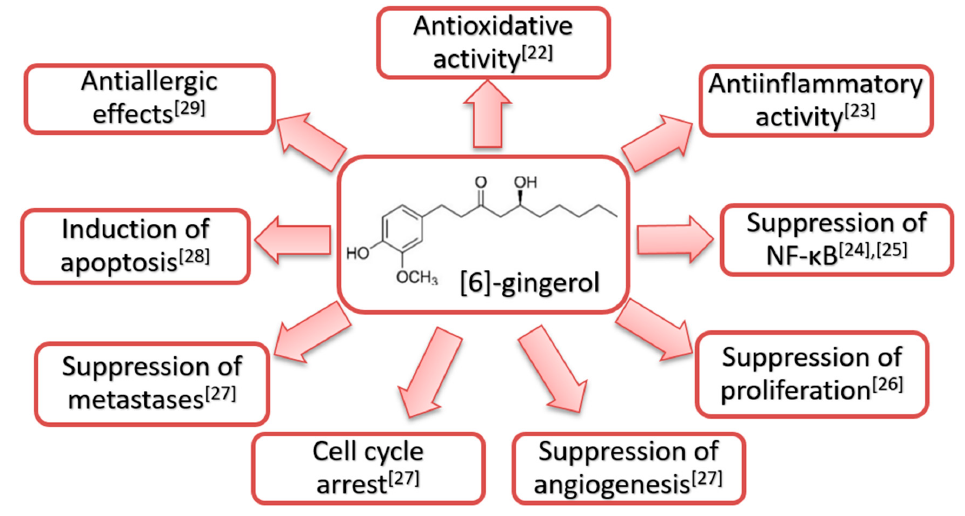
Figure 1. Structural formula and reported biological effects of [6]-gingerol [22–29].